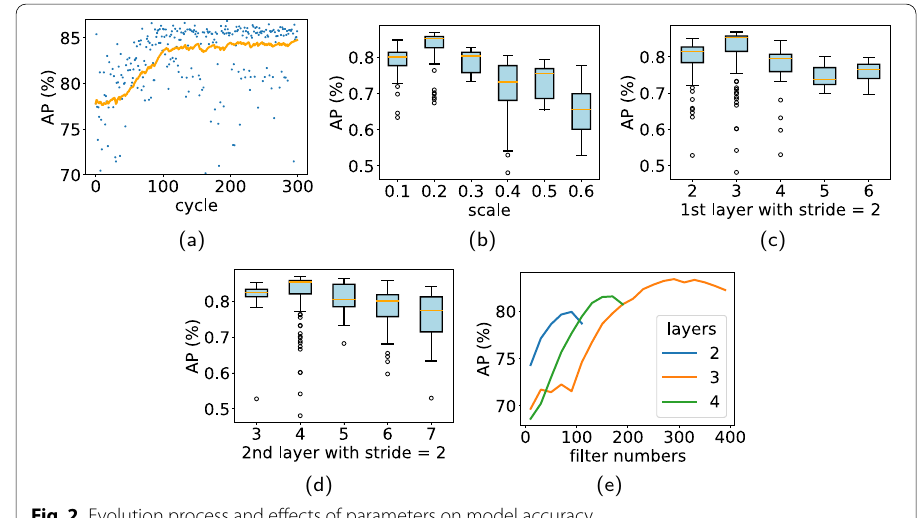
Fig. 2 Evolution process and effects of parameters on model